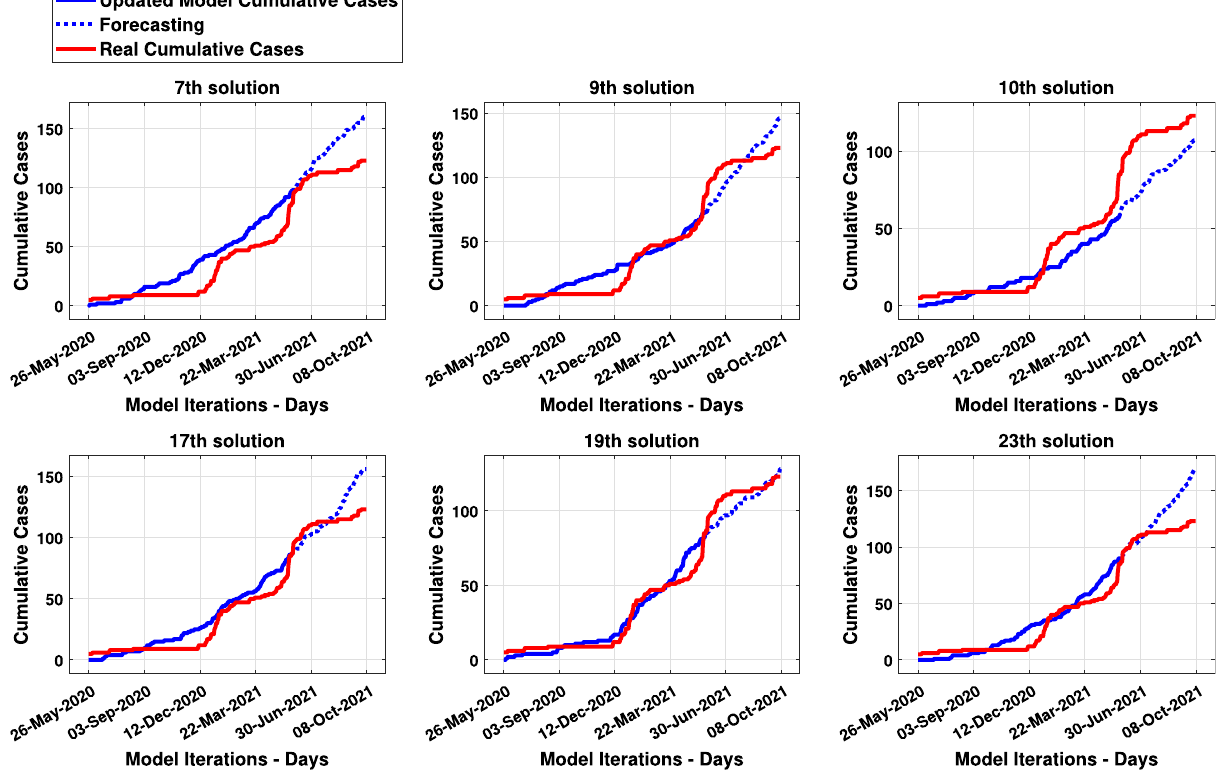
Figure 10. Updated model and real cumulative cases curves—Passa Vinte (MG)